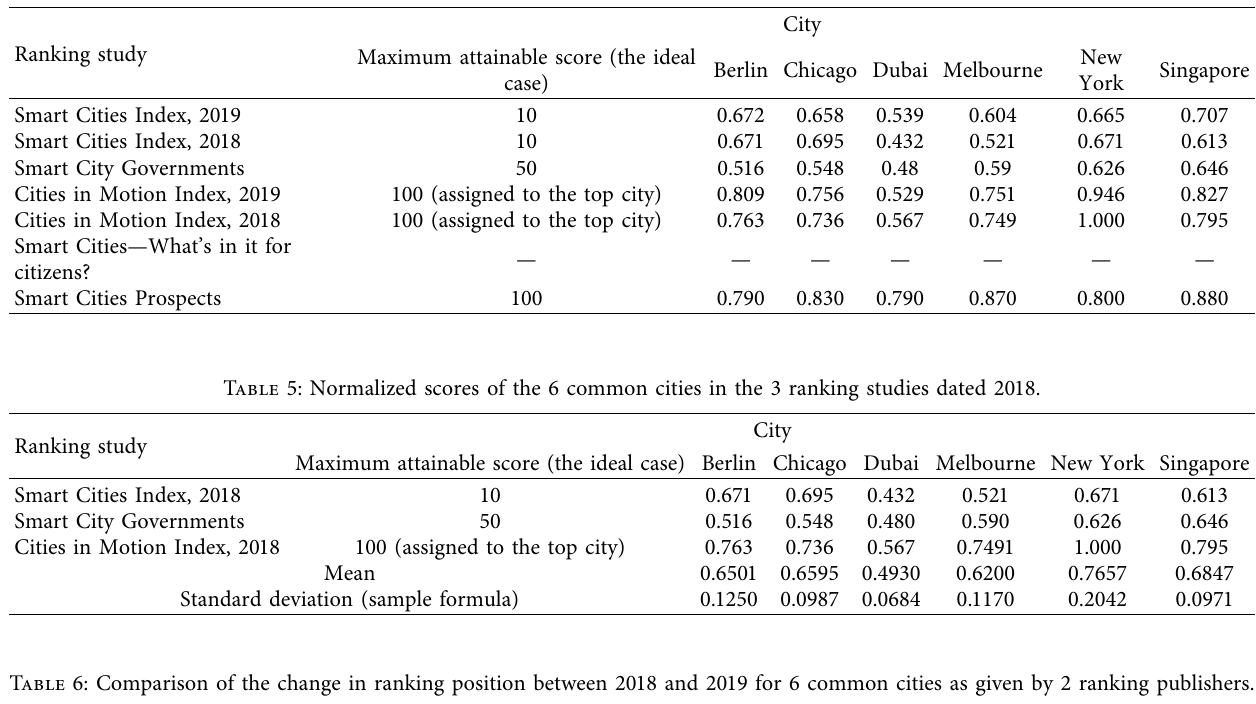
Table 4: Normalized scores of the 6 common cities in all the 7 ranking studies considered.